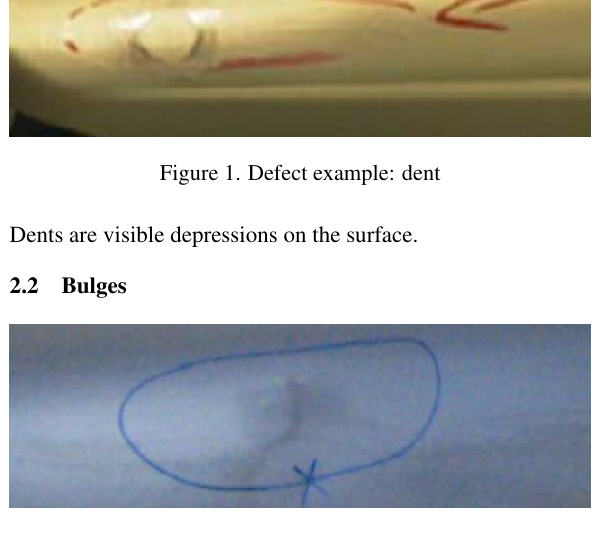
Figure 2. Defect example: bulge Bulges are visible elevations on the surface. 2.3 Notches